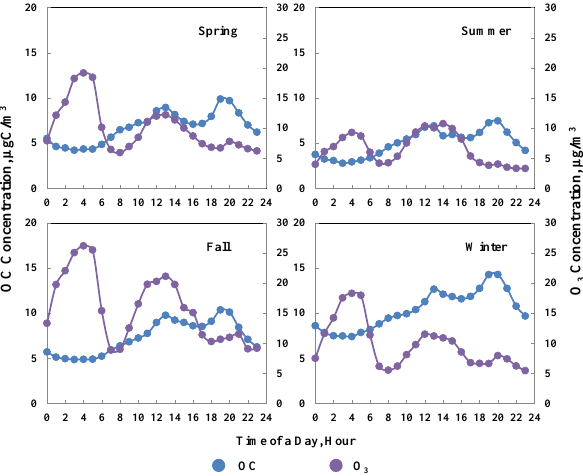
Figure 5 . Diurnal variations of OC (µgC/m 3 ) and O 3 (µg/m 3 ) at MK AQMS during different Figure 5. Diurnal variations of OC (µgCm − 3 ) and O 3 (µgm − 3 ) at seasons. See text for the explanation of the early morning O 3 peak. MK AQMS during different seasons. See text for the explanation of the early morning O 3